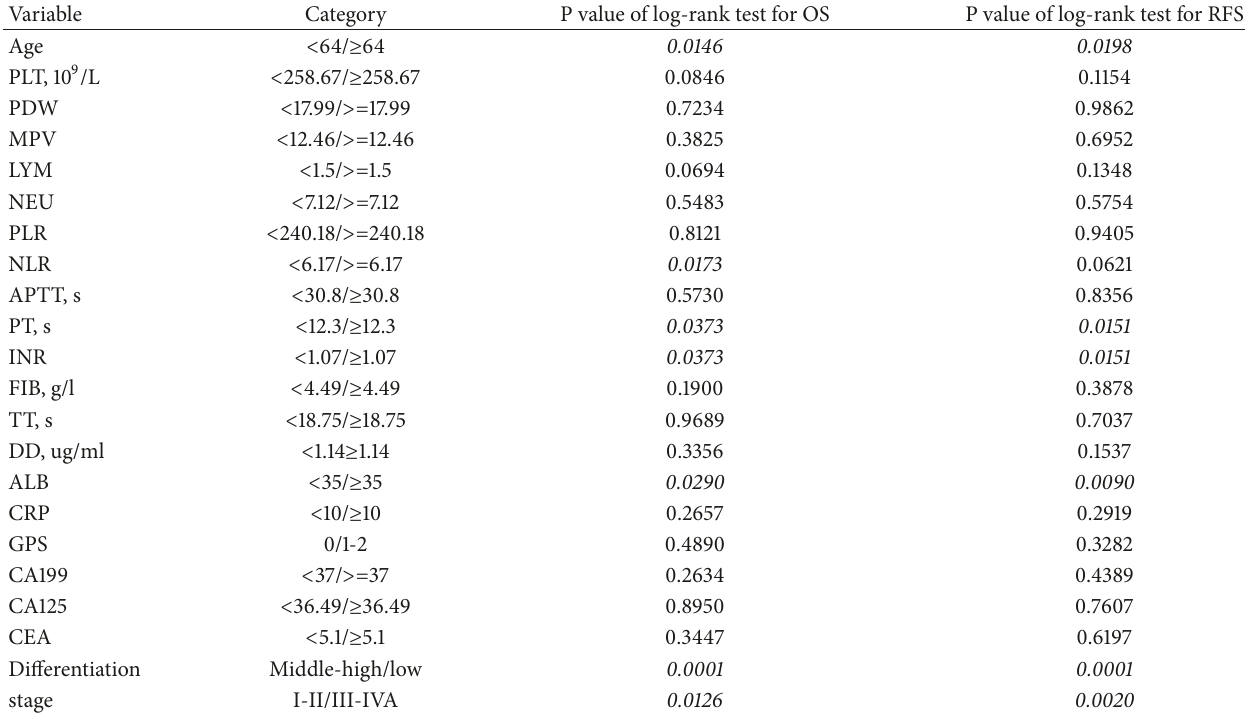
Table 5: Log-rank test for overall survival (OS) and recurrence-free survival (RFS).